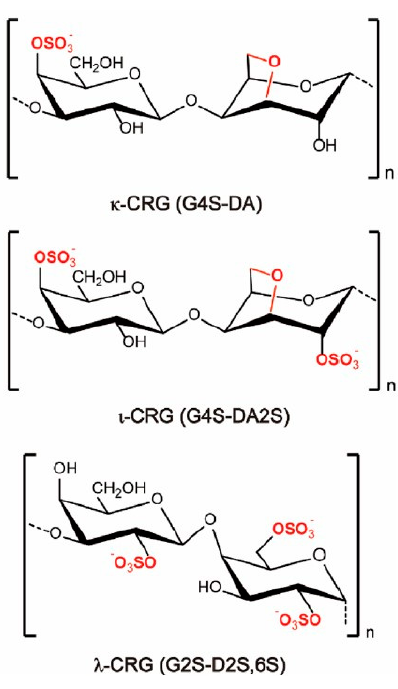
Figure 1 . Idealised chemical structures of κ -, ι -, and λ -CRG. G, DA, and D refer to the β -D-Galp, 3,6- anhydro- α -D-Galp, and α -D-Galp units, respectively (taken from [38] with permission from Else- vier).